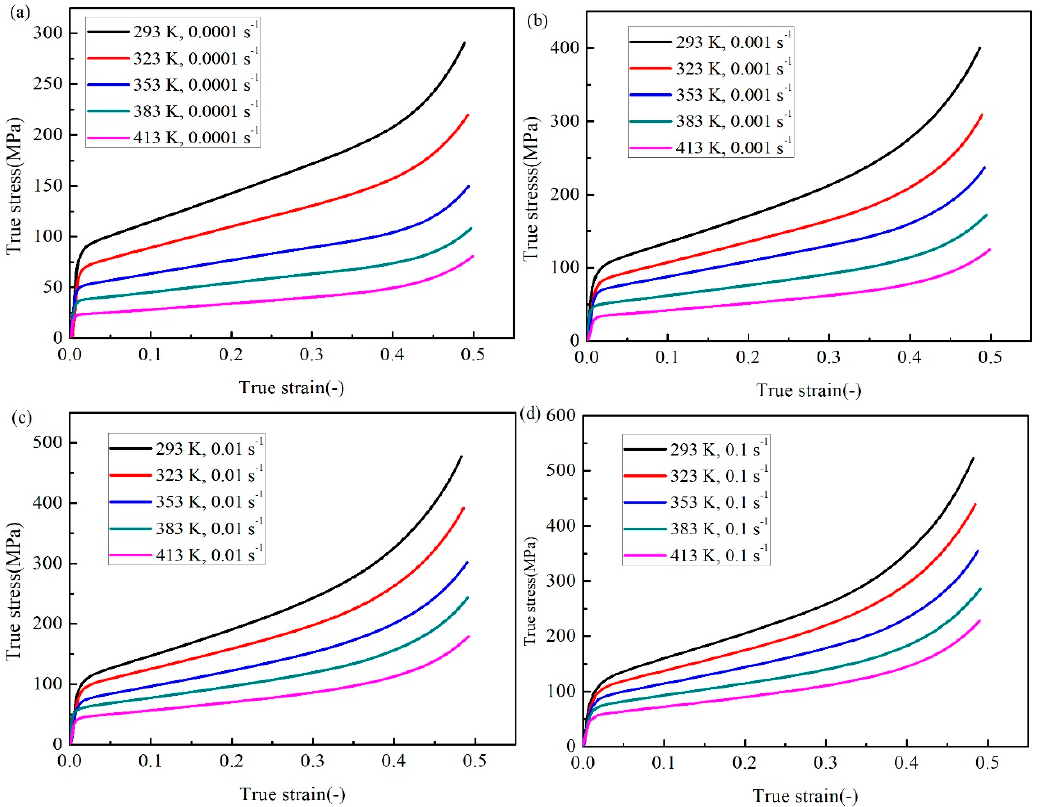
Figure 2. The true strain-stress experimental results for different temperatures and the strain rate of ( a ) 0.0001 s − 1 , ( b ) 0.001 s − 1 , ( c ) 0.01 s − 1 , and ( d ) 0.1 s − 1 .